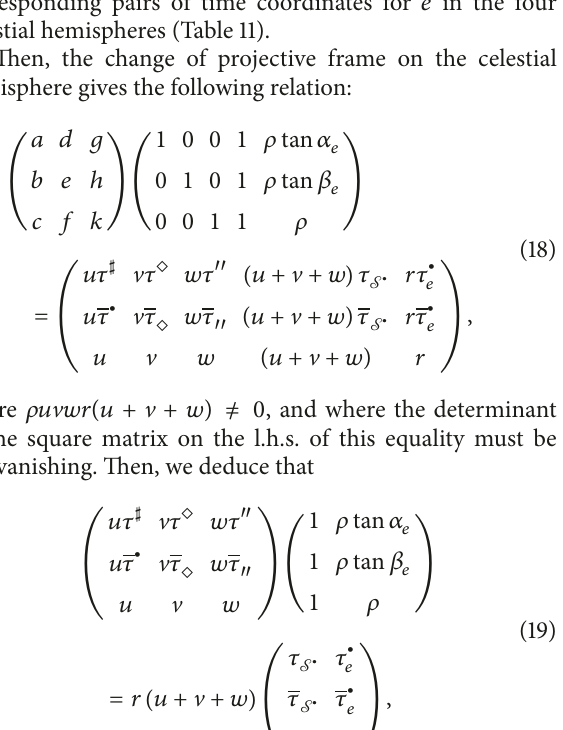
Table 7: The four primary events and their secondary/ancillary events with their corresponding projective points on the celestial hemispheres C C C ̃ , and C ̂ homeomorphic to 𝑃 R 2 . 퐸 𝑝 , 퐸 𝑝 , 퐸 𝑝 퐸 𝑝 Echoing system Primary event [∞,0] [0,∞] [0, 0] [1, 1] E ch 𝐸 ∈ W 𝐸 ∙ ̃𝐸 ∙ ̂𝐸 ∙ S ∙ 푝 E ch 𝐸 ∈ W ̃𝐸 † ̂𝐸 † 𝐸 † S † 푝 ̃ E ̃𝐸 ∈ ̃ W ̂𝐸 ∗ 𝐸 ∗ 𝐸 ∗ S ∗ ch 푝 ̂ E ̂𝐸 ∈ ̂ W 𝐸 耠 𝐸 耠 ̃𝐸 耠 S ch 푝